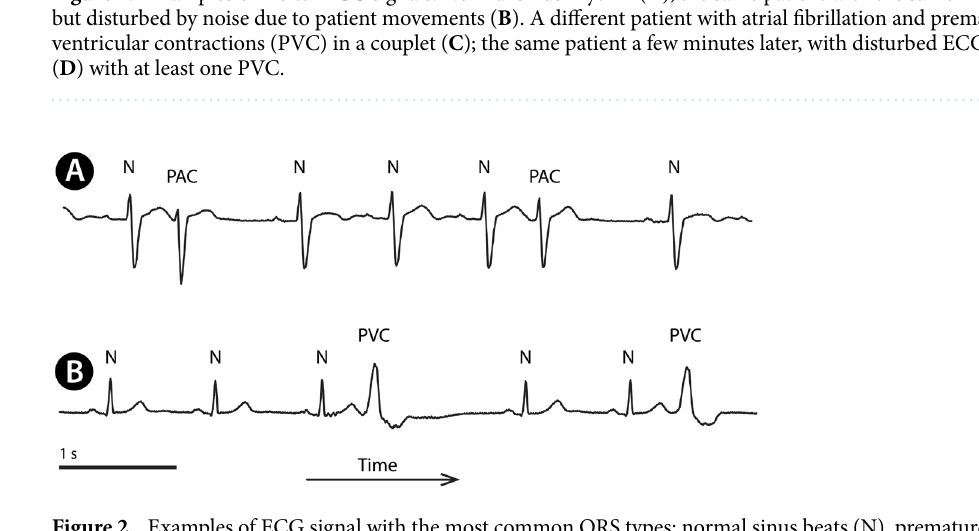
Figure 2. Examples of ECG signal with the most common QRS types: normal sinus beats (N), premature atrial contractions ( A , PAC), and premature ventricular contractions ( B ,